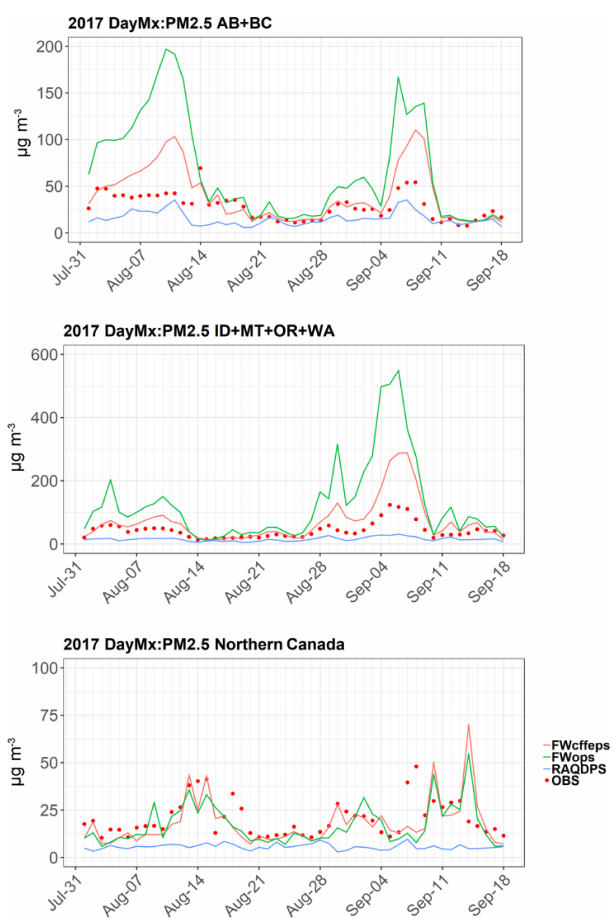
Figure 8. Time series of mean daily maximum PM 2 . 5 concentration (µgm − 3 ) from 1 August to 18 September 2017 for the three fore- cast models and surface measurements (OBS) averaged across mea- surement stations in the AB + BC, ID + MT + OR + WA, and northern Canada